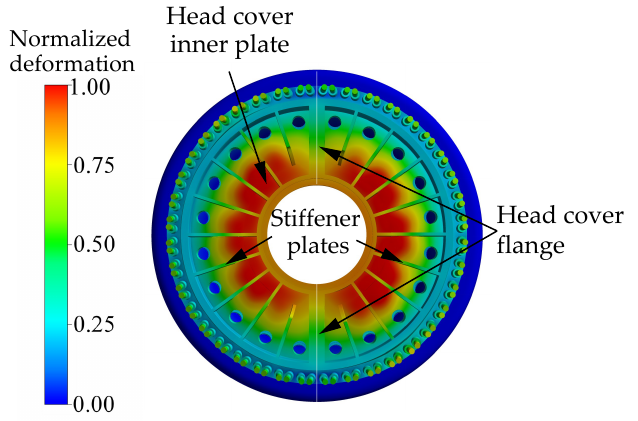
Figure 16. Deformation distribution of the stationary structures in top view. The flow-induced stress distribution during turbine load rejection in the large station- ary structures of the unit including the head-cover, stay ring and bottom ring is shown in Figure 17. The large hydraulic pressure acts on the stationary structures of the unit, pressing the bottom ring downward and lifting the head-cover. As a result, the guide vanes between them are stretched. Since the trailing edge of the stay vane is much thinner than the leading edge, the maximum flow-induced stress is concentrated at the rounded corner of the trailing edge of the stay